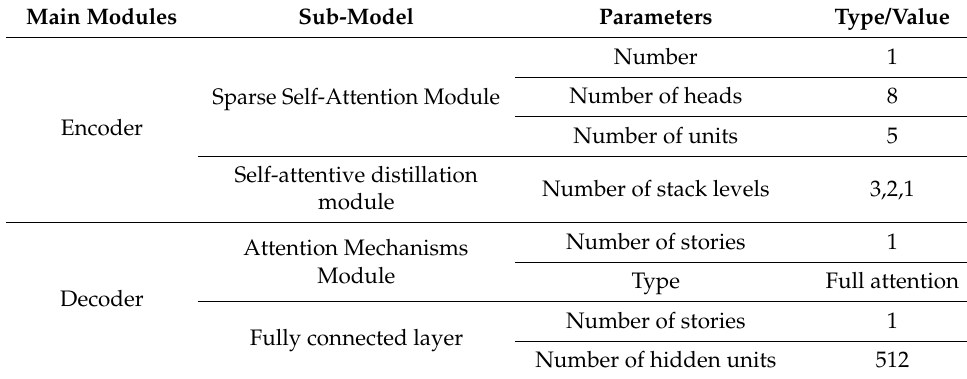
Table 3. The Parameters of the Informer model. Main